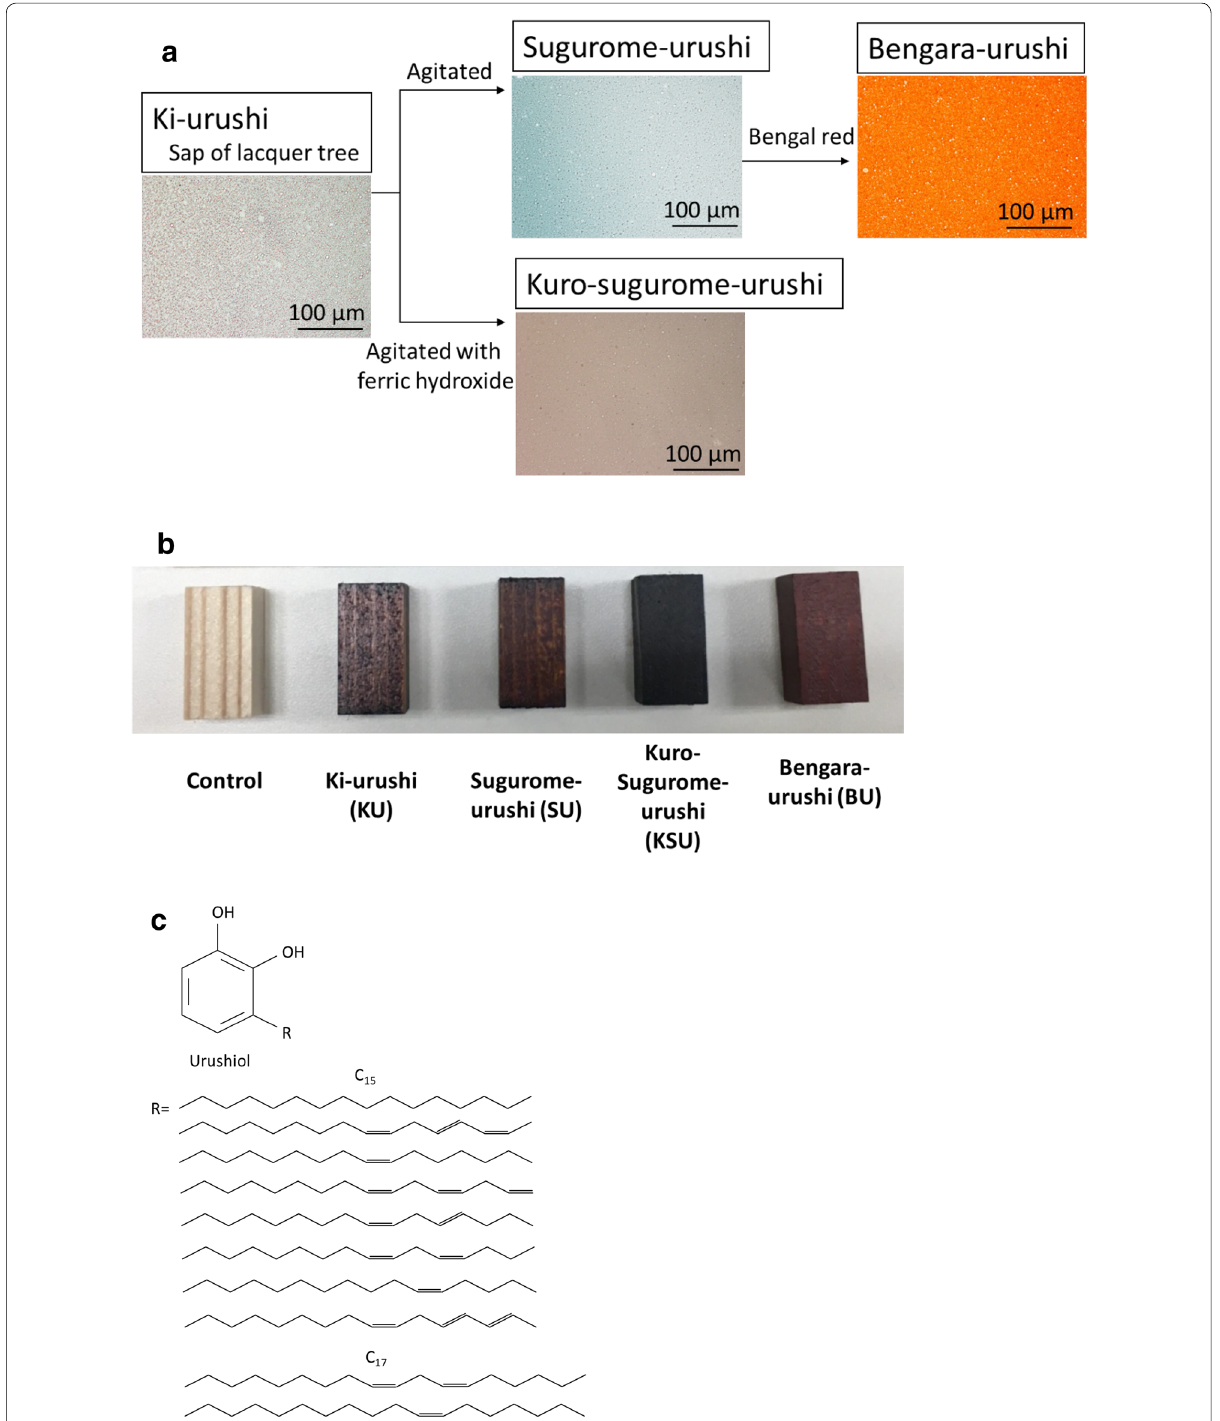
Fig. 1 Schematic of each urushi sample and micrographs of each urushi sap ( a ), the samples coated with each urushi ( b ) images of each samples coated with four types of urushi ( c ), and structures of typical